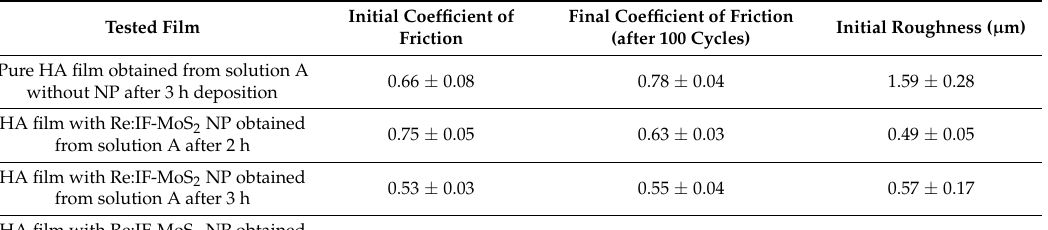
Table 4. The initial and final friction coefficients and the initial roughness of the coating on titanium substrate obtained from solution A for different periods of deposition. Measurement conditions: